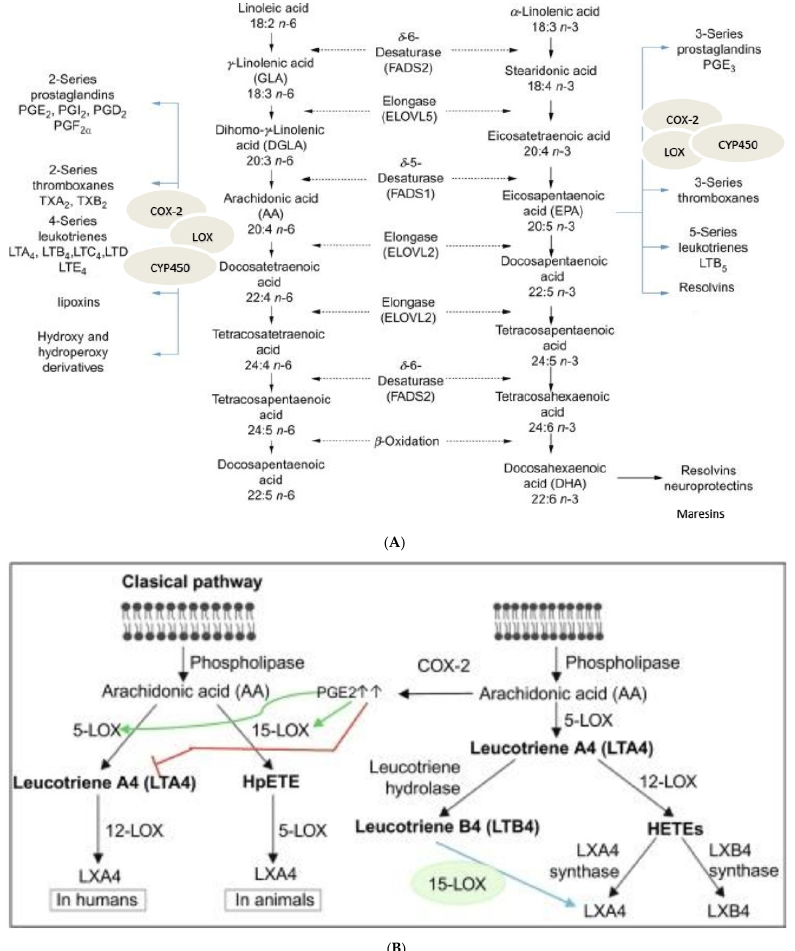
Figure 1. ( A ) Metabolism of essential fatty acids. ( B ) Metabolism of arachidonic acid. Previous studies revealed that increasing PGE2 concentrations in the tissues by the inhibition of 15-PGDH (15-prostaglandin dehydrogenase, the PGE2-degrading enzyme)